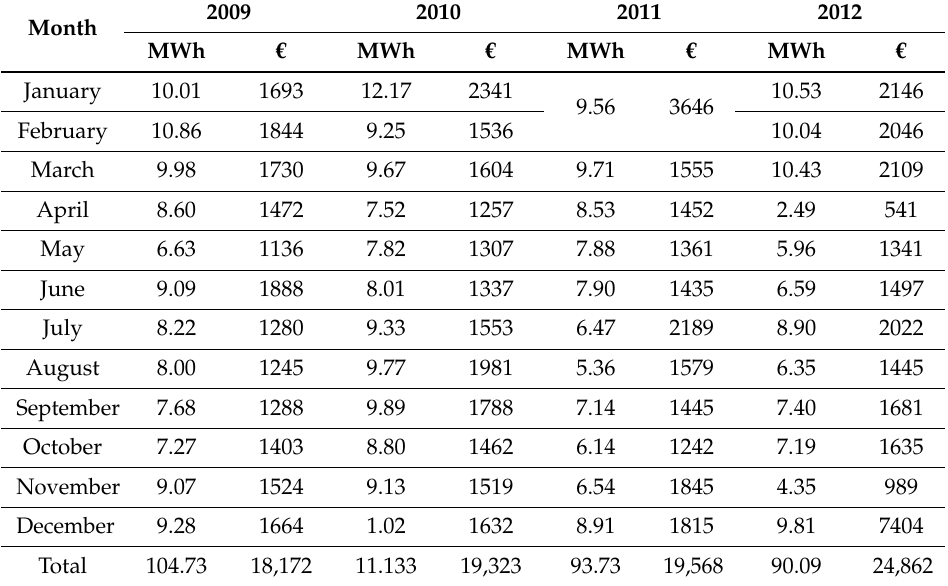
Table 6. Villa Sciarra electricity consumptions and related economic costs.